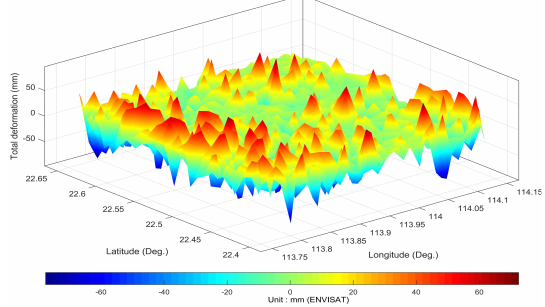
Figure 7. 3D deformation model of ENVISAT ASAR